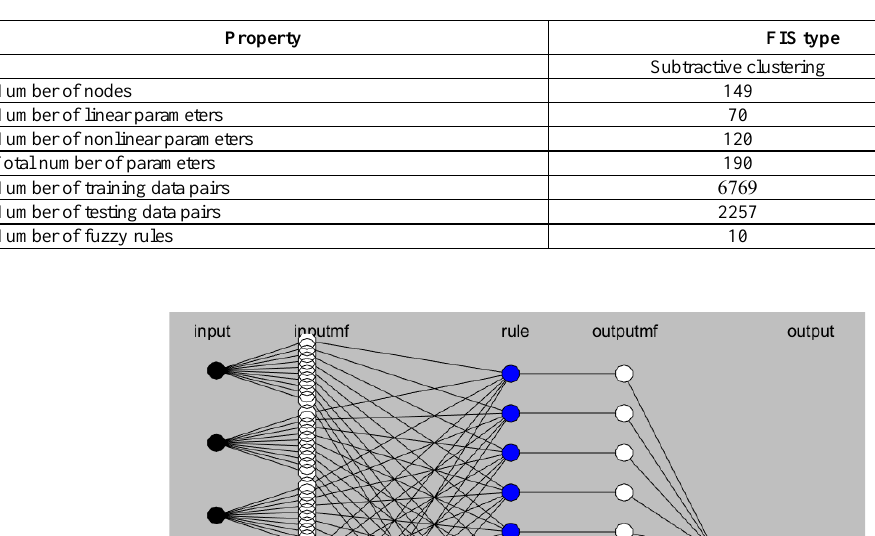
Table 5. Properties of different FIS types